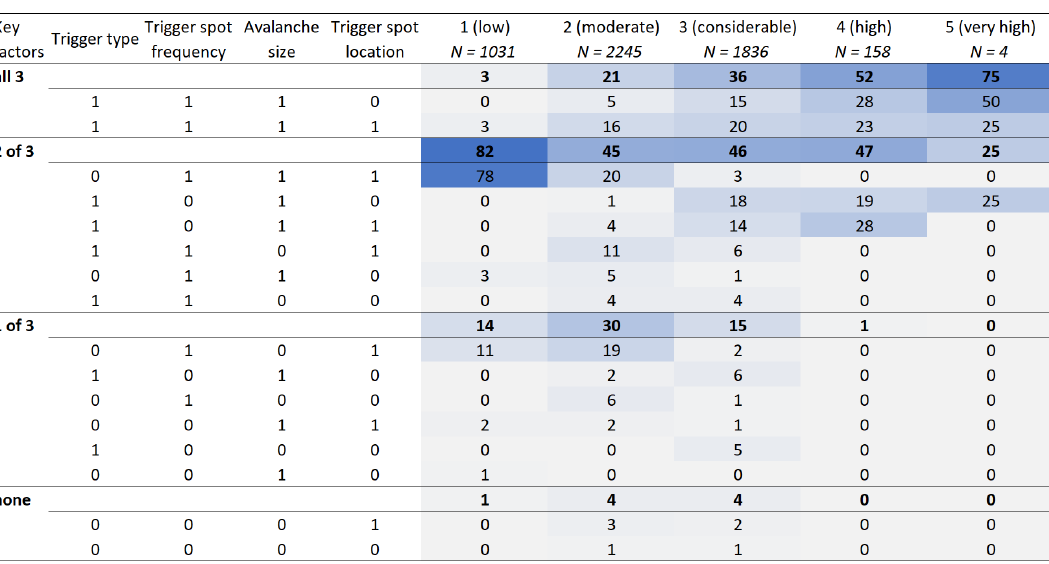
Table 5. Percentage of dry-snow danger descriptions which contained information on the key factors trigger type, frequency of triggering spots, and avalanche size. In addition, the proportion for the location of triggering spots is shown. The figure provides two levels of detail. First, the proportions that information on the three key factors characterizing avalanche danger was given in the danger description (i.e., when two of three factors were described). These proportions are highlighted bold. Second, proportions are shown for each individual combination of factors within these subgroups, with a 1 indicating when a key factor was described and 0 when a key factor was not described (i.e., in the second row, when trigger , frequency , and avalanche size were described ( = 1), but not location ( =